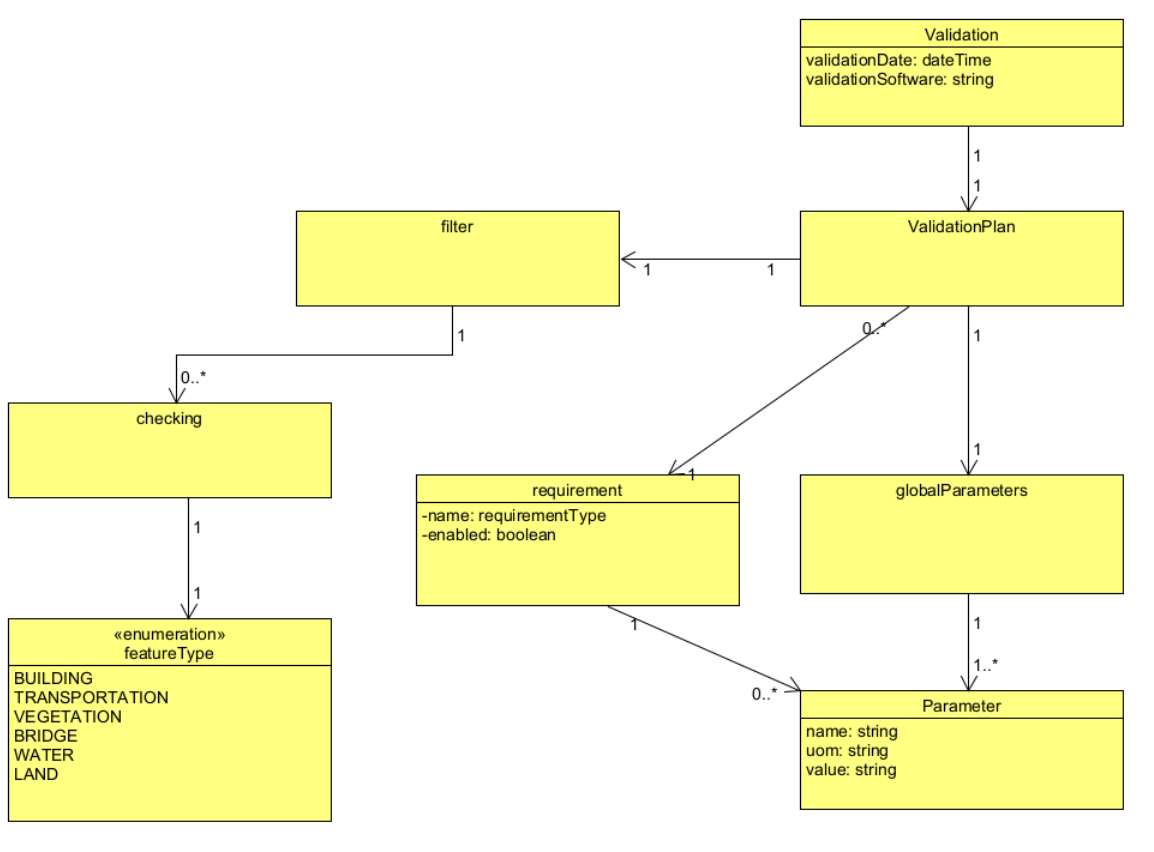
Figure 4. Validation Plan Structure